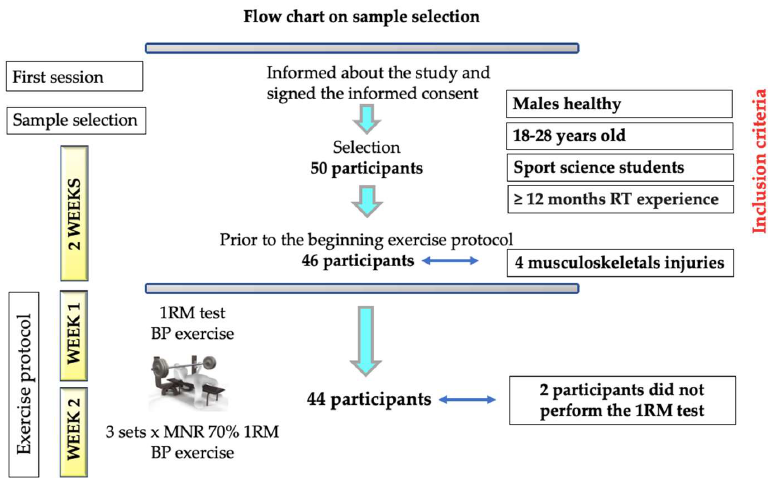
Figure 1. Flow chart on sample selection. RT = resistance training, BP = bench press, 1RM = one-repetition maximum test. MNR = maximum number of repetitions.